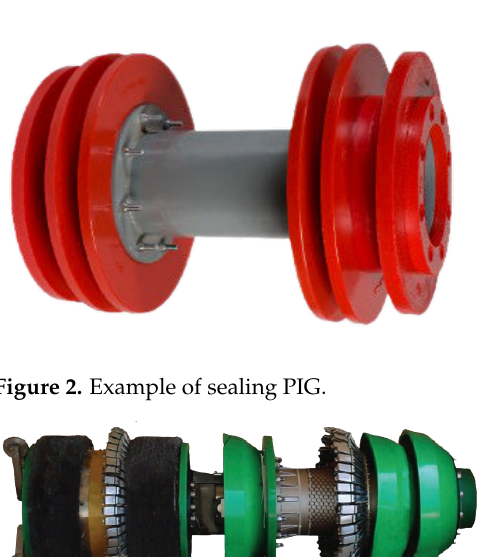
Figure 3. Example of smart PIG.